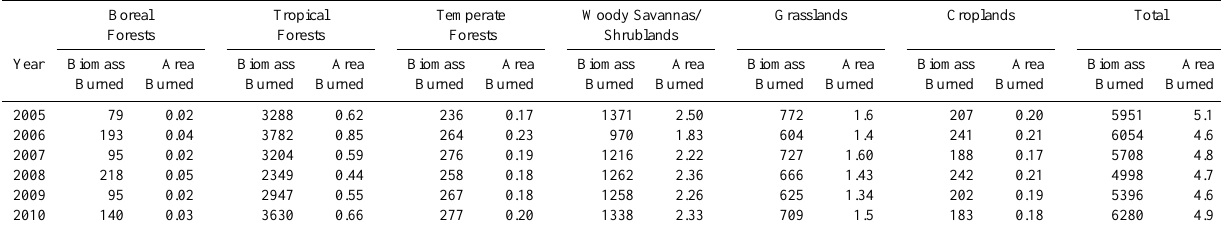
Table 7. Global annual estimates of biomass burned (Tg) and area burned (km 2 10 − 6 ) per generic LULC type for 2005–2010.